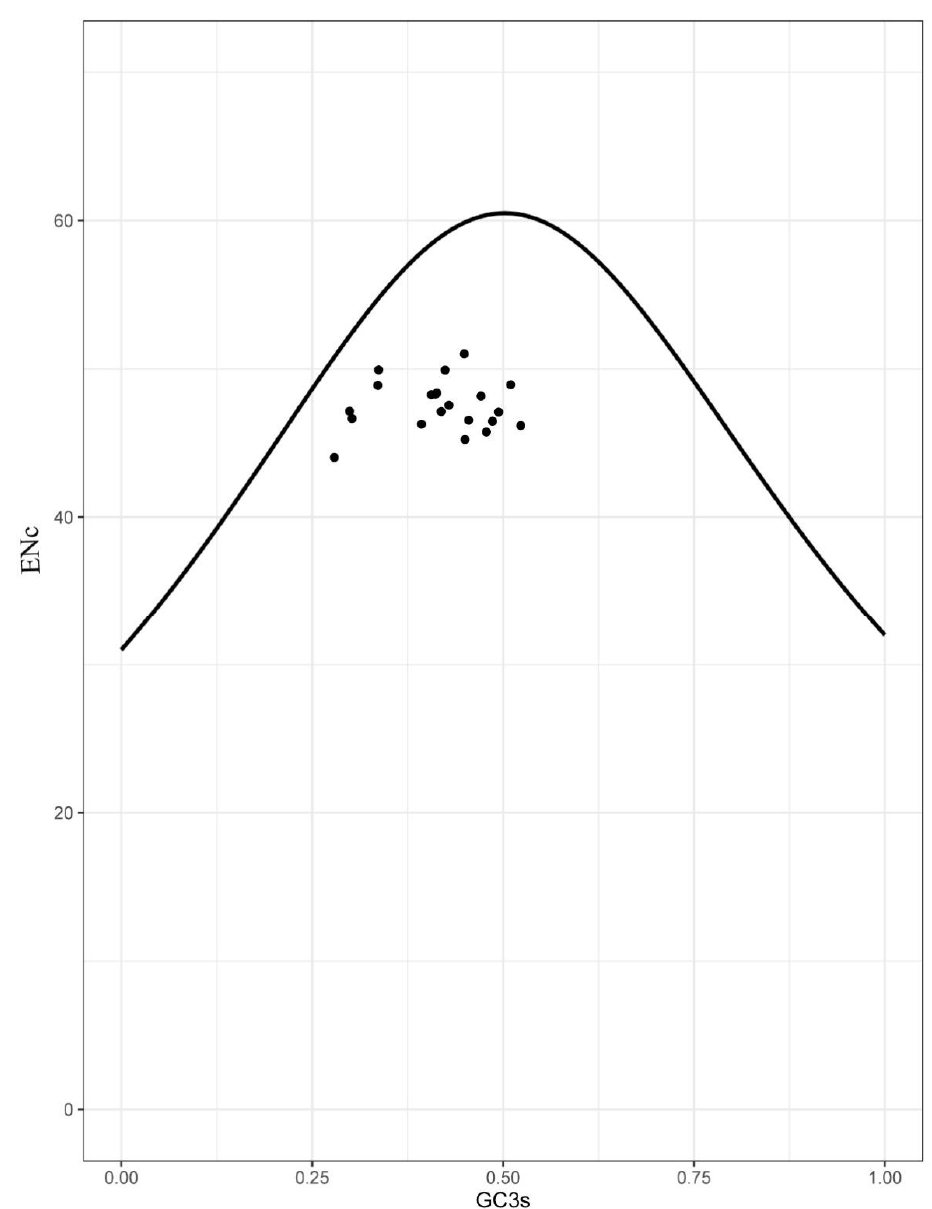
Figure 5. ENc vs. GC3 plot showed that the analyzed mitogenomes were translationally efficient and that natural selection played a crucial role in their